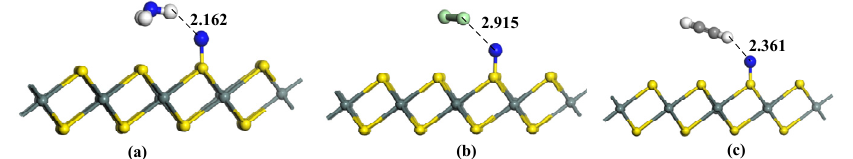
Figure 6. Gas adsorption on N-SnS 2 . ( a ) N-SnS 2 /NH 3 , ( b ) N-SnS 2 /Cl 2 , ( c ) N-SnS 2 /C 2 H 2 . The distance is Å.